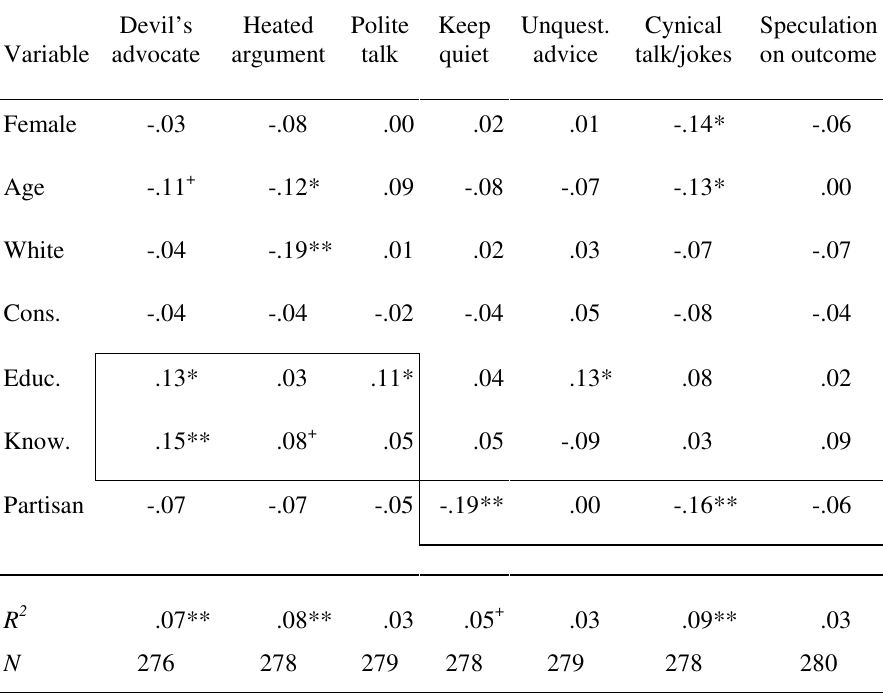
Table 4 Demographic and political predictors of ballot discussion elements